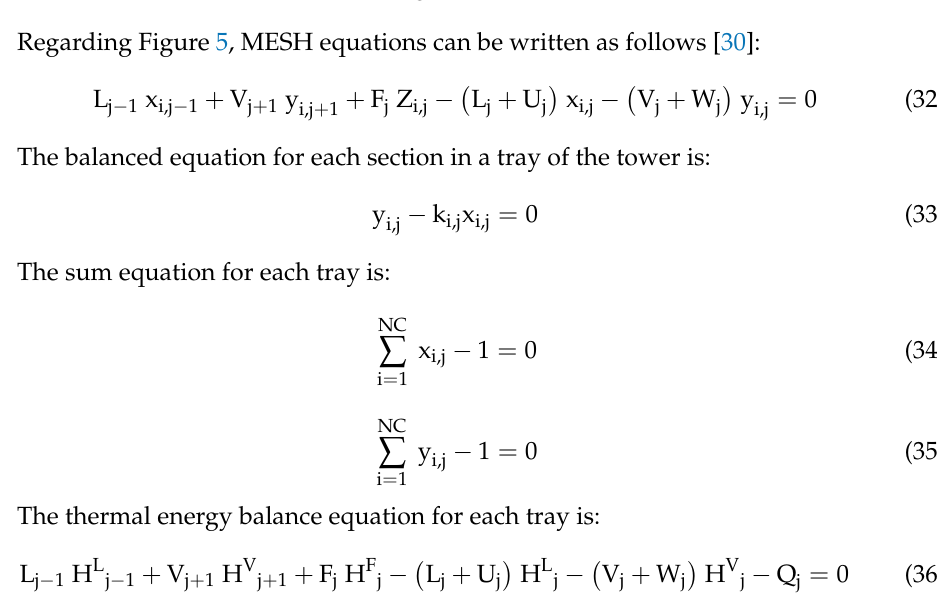
Figure 5. The overall balance in one of the stages of the distillation tower, (modified from